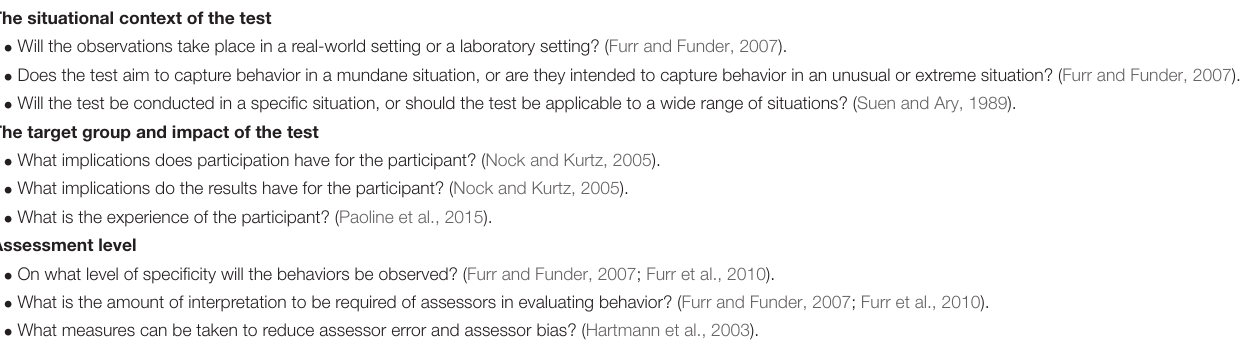
TABLE 2 | Sample questions police organizations can use to determine their test